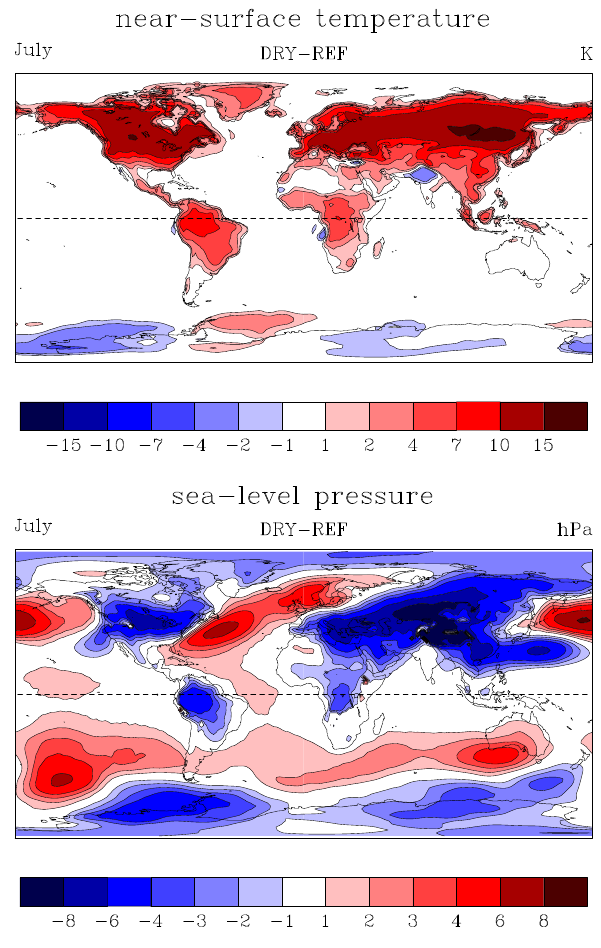
Fig. 6. Top panel: Difference in near-surface (2m) temperature in July (K, DRY-REF). Bottom: Difference in pressure reduced to sea-level in July (hPa, DRY-REF). See Fig. S5 in the Supplement for